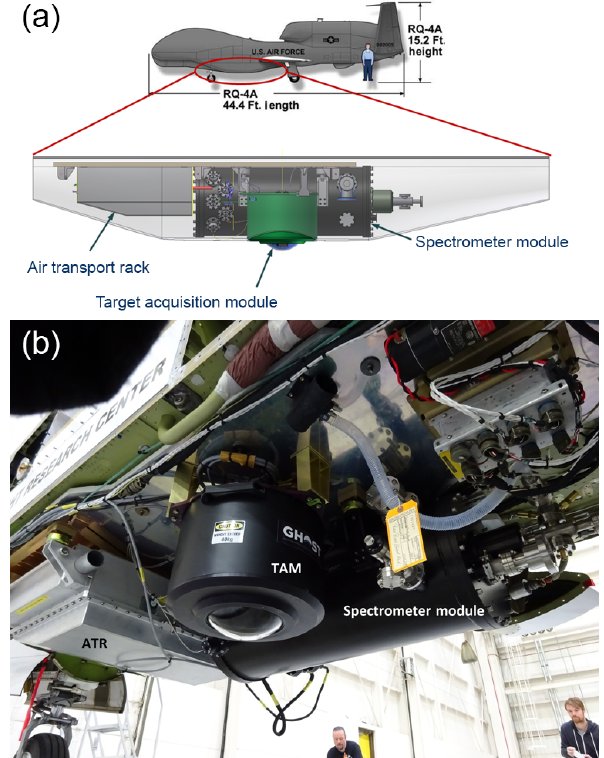
Figure 1. (a) Layout of the three main GHOST components mounted in the lower instrument bay of the NASA Global Hawk. (b) Photograph taken from below showing the GHOST installation on the Global